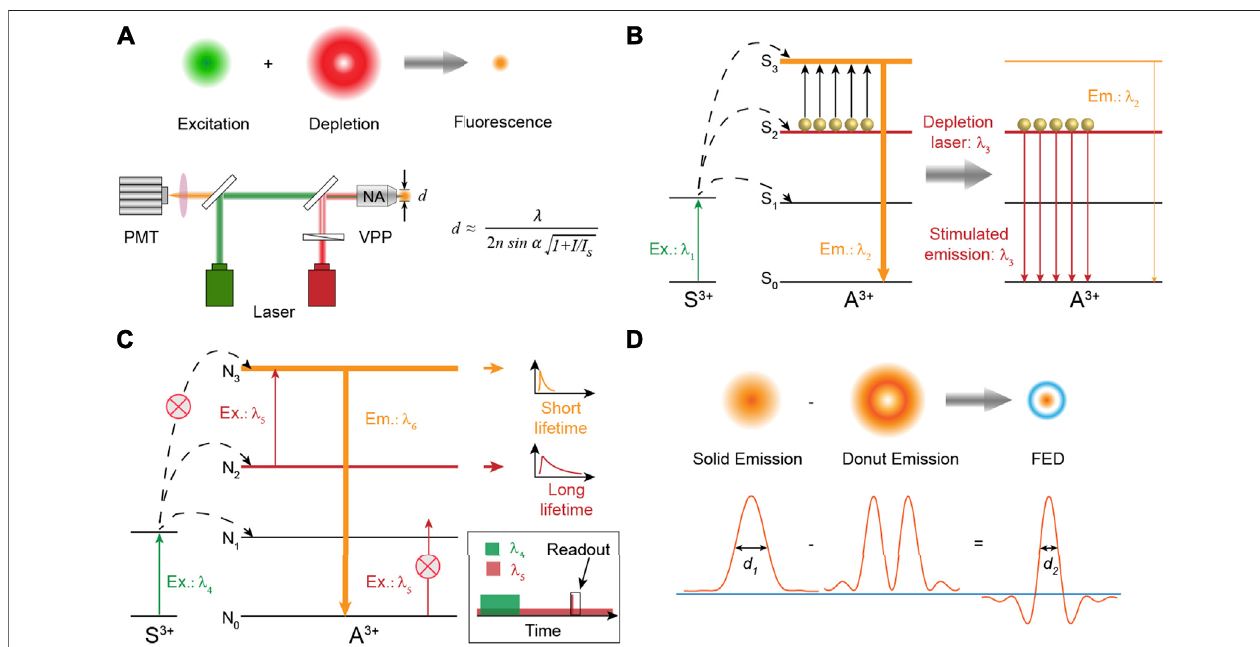
FIGURE 1 | (A) Schematic diagram showing the principle of super-resolution imaging and the simpli fi ed setup of STED nanoscopy. VPP: vortex phase plate. The formuladescribestheresolutionofSTEDnanoscopy. d isthediameterofthespotthat fl uoresces. (B) TheenergytransferpathwayoftypicalTm 3+ -basednancrystalsfor super-resolution. Stimulatedemission istriggered under a λ 3 laserexcitation todeplete the population ofenergy state S 3 . (C) Theenergy transferpathway oftheexcited state absorption process to achieve super-resolution through separated time – domain detection. (D) Theoretical results of point spread functions obtained in fl uorescence emission difference microscopy. The negative values caused by the intensity subtraction are set to zero to ensure a better spatial resolution.